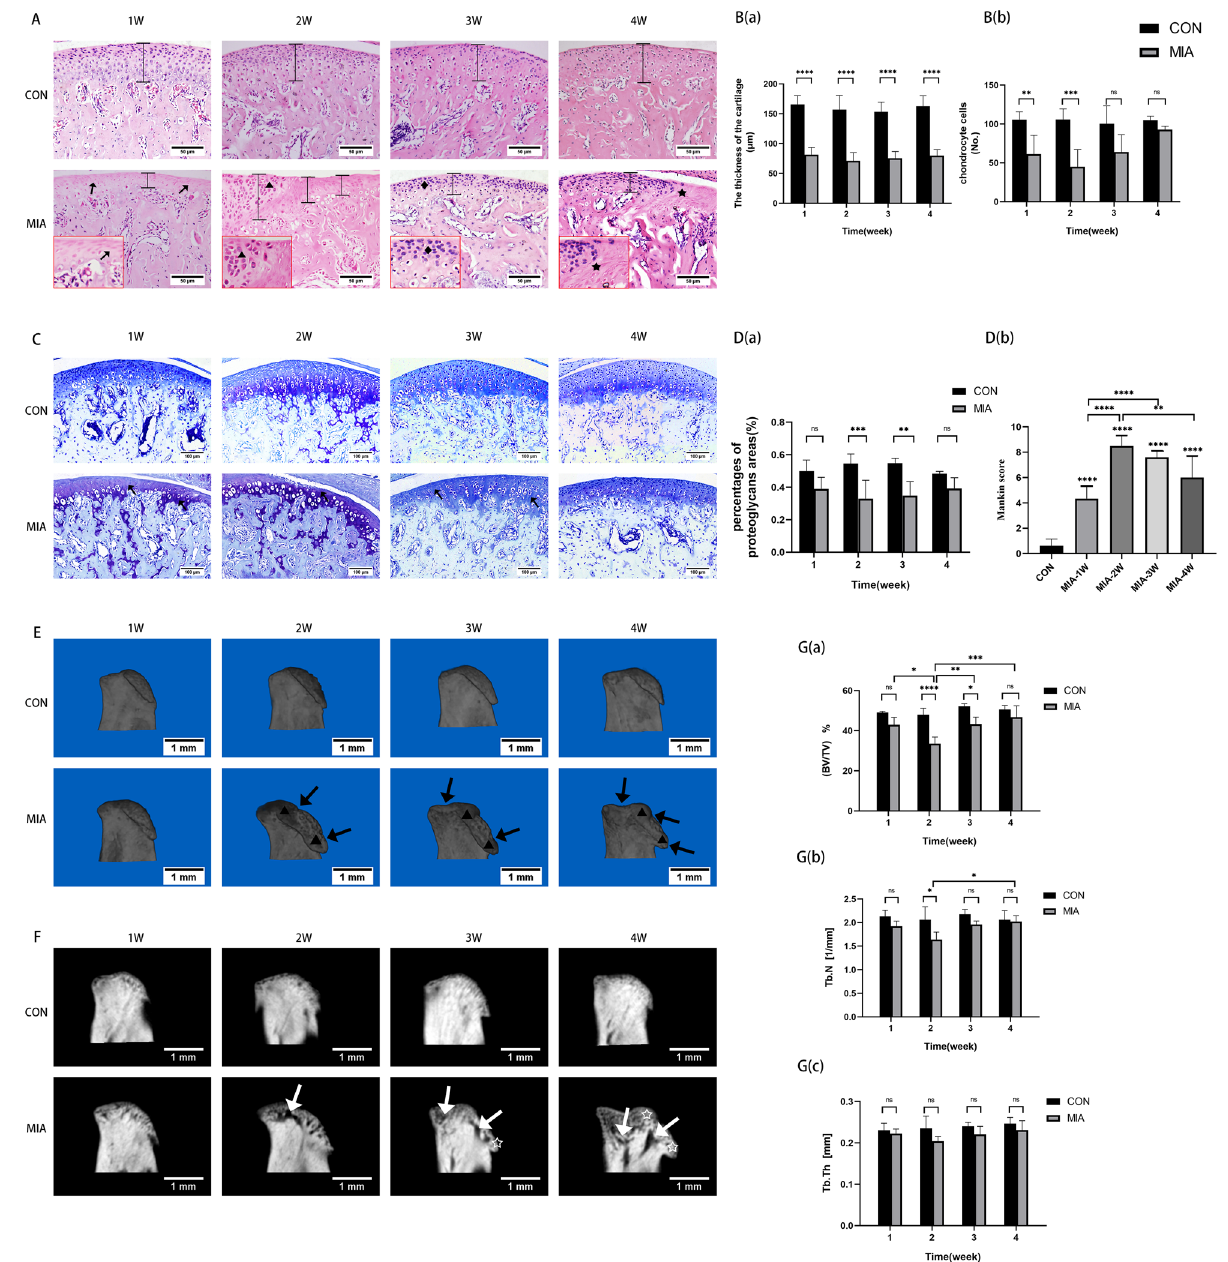
Figure 2. (A) Hematoxylin & eosin (H&E) staining of TMJ. 工 : the thickness of cartilage. Arrows: the degraded cartilage areas. Black triangles: chondrocyte clustered area. Black quadrilaterals: disorder of cartilage layer. Black pentacles: fibrous degeneration of cartilage layer. (B) Quantitative analysis of cartilage thickness and the number of chondrocyte cells. (C) Toluidine blue (TB) staining of TMJ. Arrows: the degraded cartilage areas. (D) The percentages of the proteoglycans areas of the condylar cartilage and the Mankin scores. (E) Three ‐ dimensional image of the condyle. Black arrows: bone destruction depression. Black triangles: osteophytes. (F) The image of the sagittal plane of the condyle. White arrows: cystic degeneration. Pentacles: osteophytes. (G) Quantitative analysis of the structural parameters of subchondral bone by micro ‐ CT. CON control group (n = 5). MIA: TMJ OA model group (n = 5). ns no significance. * P < 0.05; ** P < 0.01; *** P < 0.001; **** P <